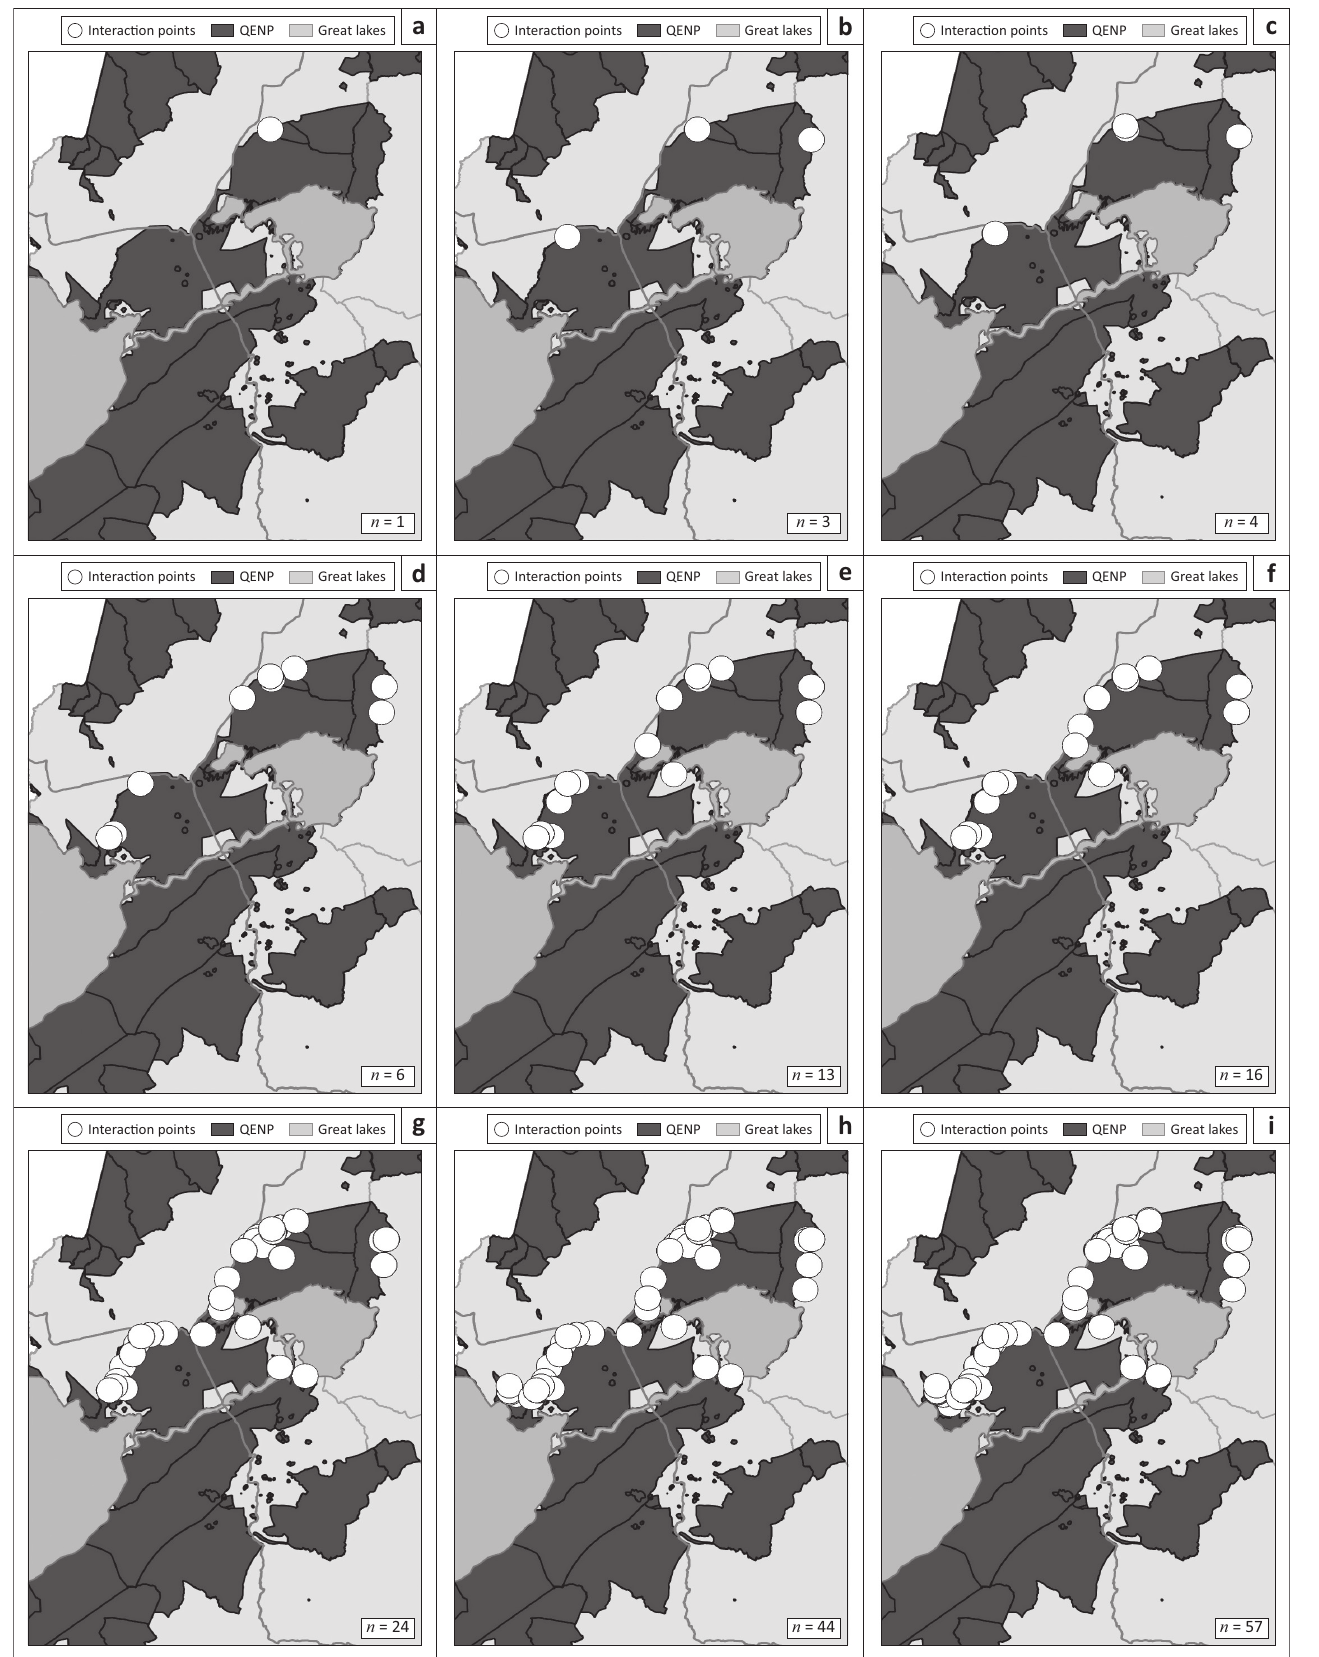
FIGURE 2: Queen Elizabeth National Park showing points of spatio-temporal overlap ( n ) between buffalo and cattle within (a) 2 weeks and 150 m, (b) 4 weeks and 150 m, (c) 6 weeks and 150 m, (d) 2 weeks and 300 m, (e) 4 weeks and 300 m, (f) 6 weeks and 300 m, (g) 2 weeks and 500 m, (h) 4 weeks and 500 m and (i) 6 weeks and 500